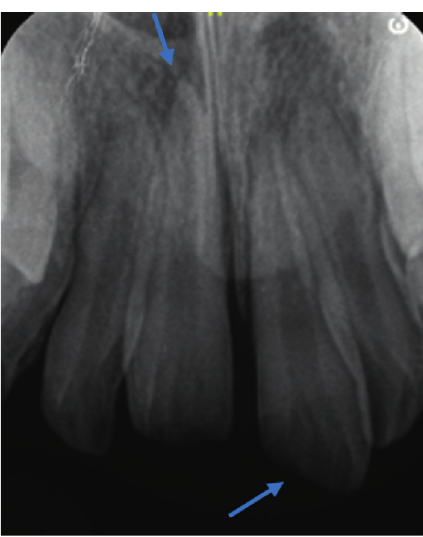
Figure 2: Intrusion injury of the UR1 (left arrow) and a com- plicated mesial incisal fracture of the UL1 (right arrow).